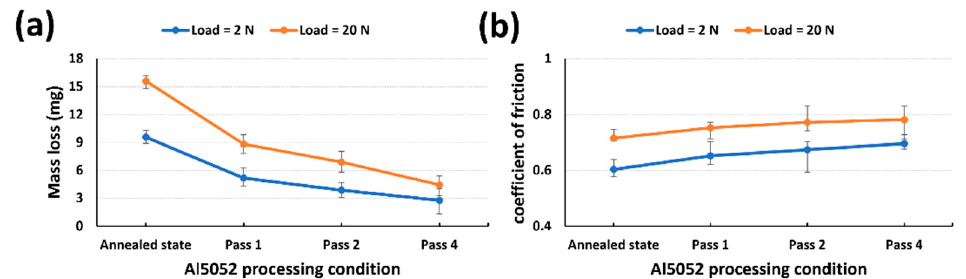
Figure 6. Tribological behavior of the AA5052 before and after the CEC process with different numbers of passes for two applied normal loads of 2 and 20 N: ( a ) wear mass loss and ( b ) coefficient of friction.